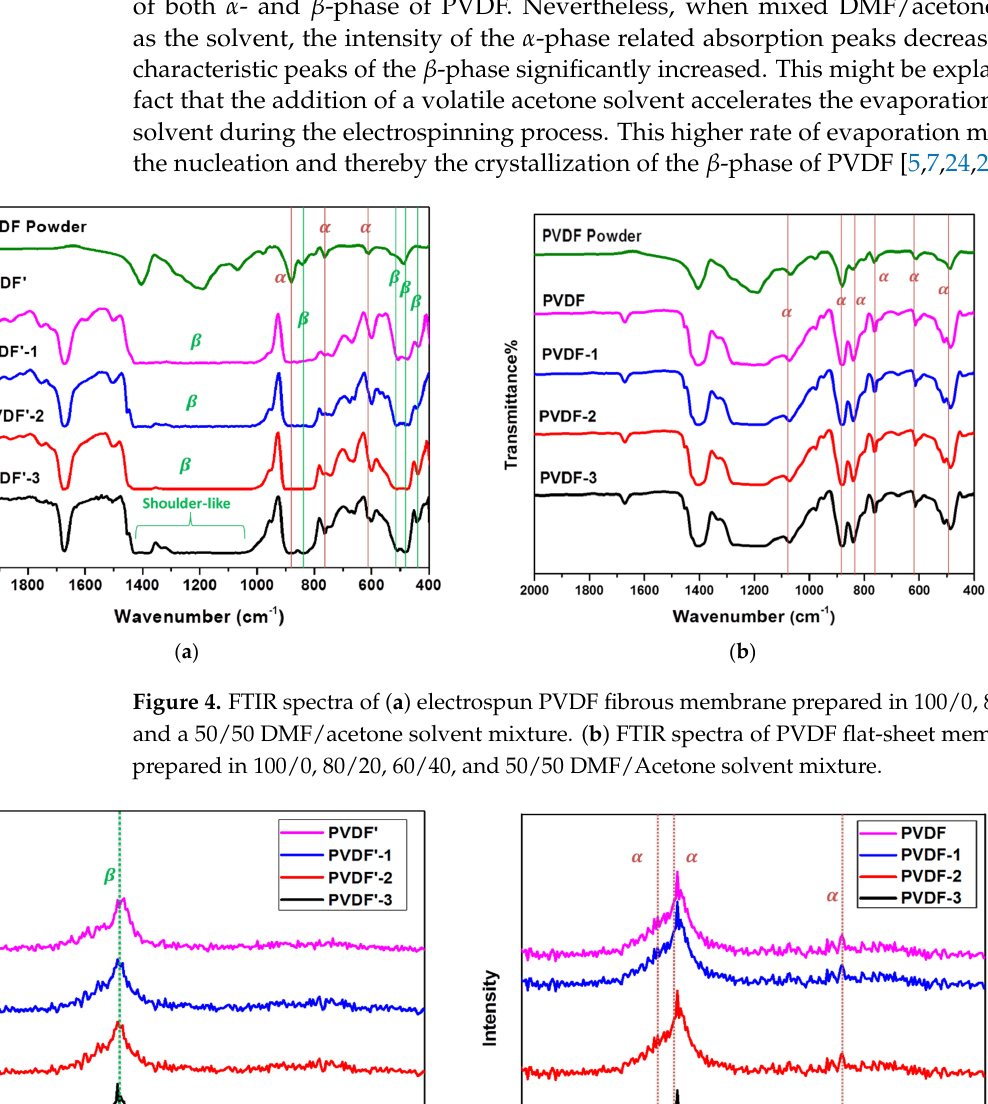
Figure 5. ( a ) The XRD diffraction patterns of electrospun PVDF fibrous membranes were prepared in 100/0, 80/20, 60/40, and 50/50 DMF/acetone solvent mixture. ( b ) The XRD patterns of PVDF flat- sheet membranes were prepared in 100/0, 80/20, 60/40, and 50/50 DMF/acetone solvent